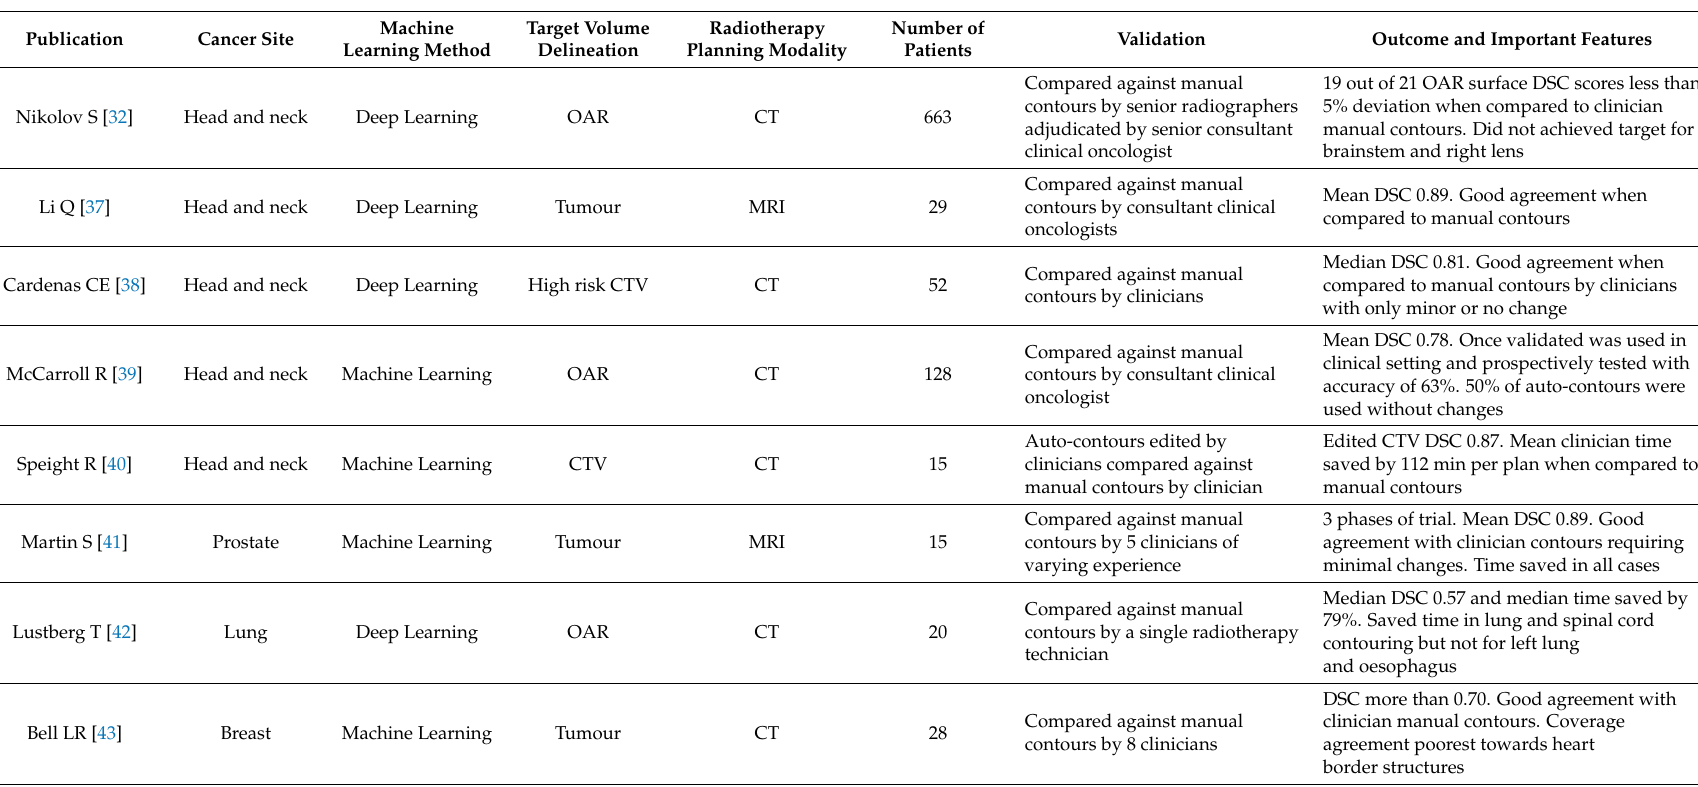
Table 1. Relevant publications on machine learning approaches to radiotherapy target delineation. Abbreviations: organ at risk (OAR), computed tomography (CT), Dice similarity coefficient (DSC), magnetic resonance imaging (MRI), clinical target volume